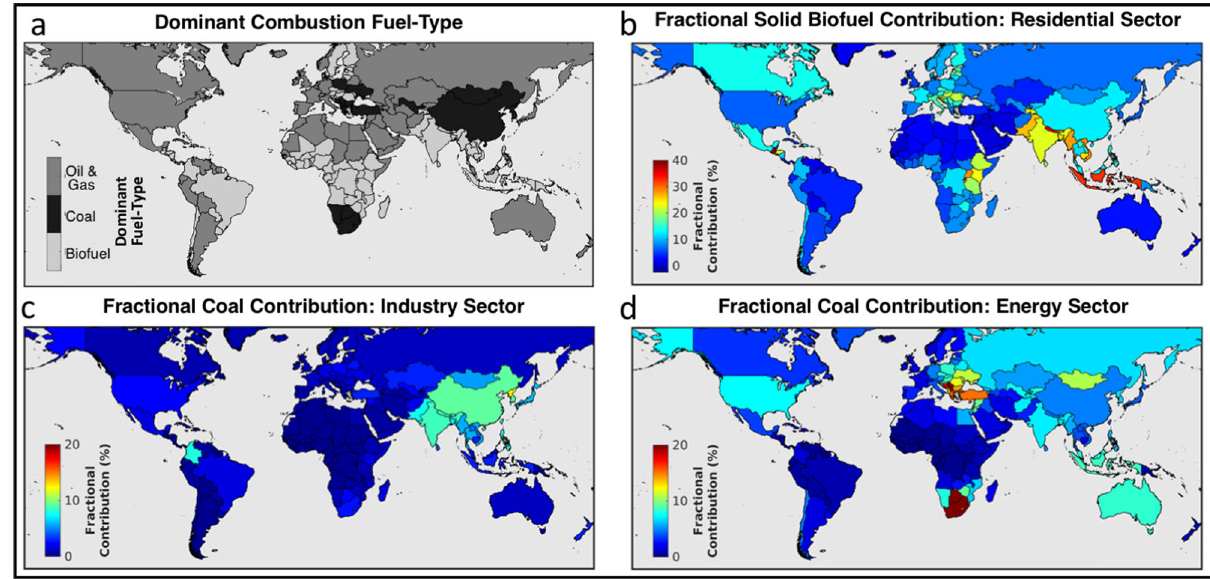
Fig. 4 Fractional contributions from select combustion fuel types and sectors. a The combustion fuel-type with the largest relative contribution to PM 2.5 mass and mortality in each country. b – d The fractional contributions from solid biofuel combustion in the residential sector ( b ), coal combustion in the industry sector ( c ), and coal combustion in the energy sector ( d ). Note the color scale change between ( b ) and ( c , d